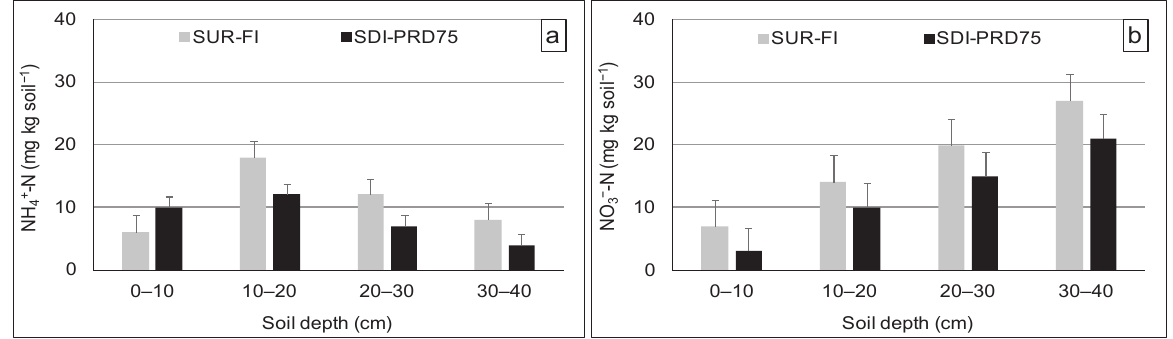
Values within the column followed by different letters are significantly different based on least significant difference (LSD) at P ≤ 0.05. FI = full irrigation; PRD = partial root zone drying; RDI = regulate deficit irrigation; SDI = subsurface drip irrigation; SUR = surface drip irrigation.